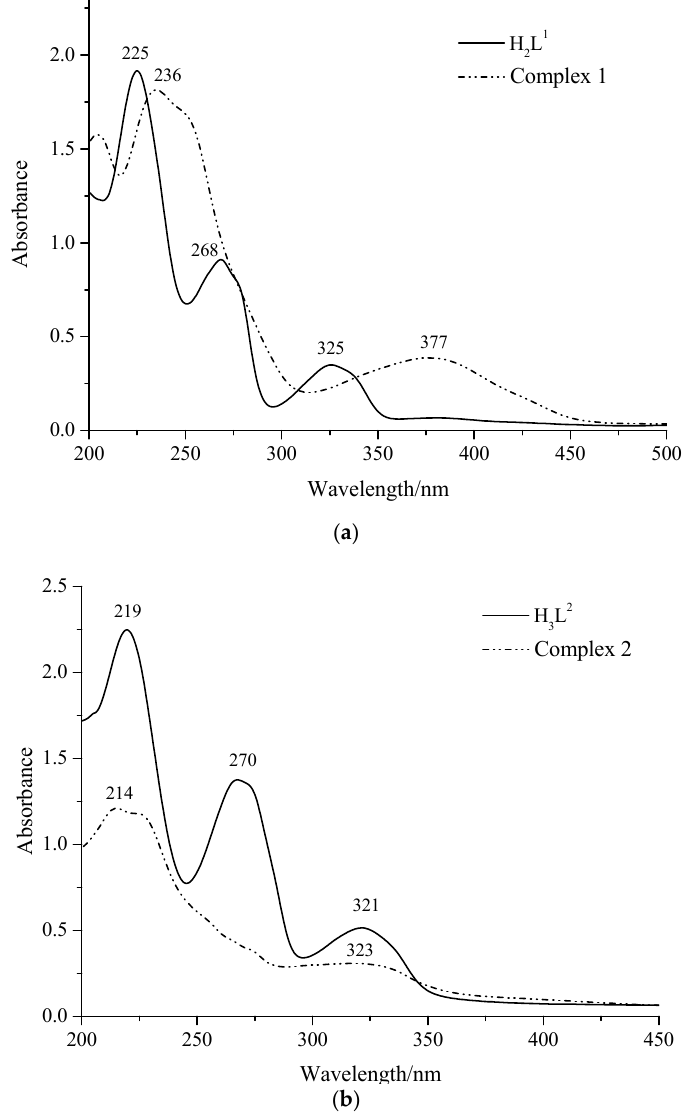
Figure 5. UV-vis spectra of: ( a ) H 2 L 1 ; and ( b ) H 3 L 2 , and their corresponding complexes 1 and 2 .